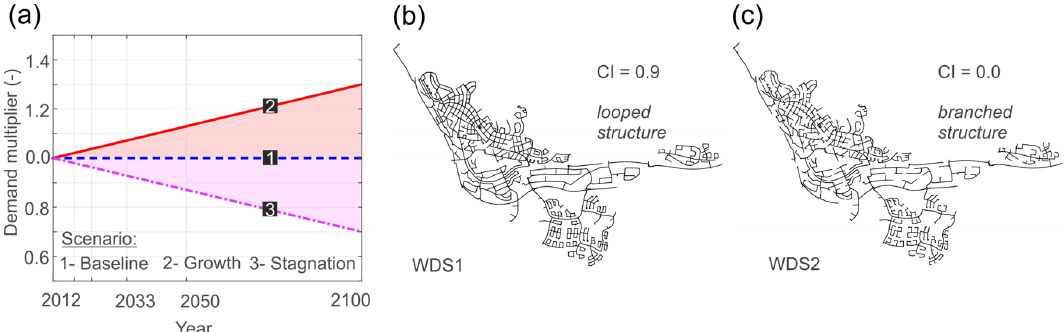
Figure 6. Future demand scenarios ( a ) and two possible planning options (WDS1 & WDS2) with different network structure ( b ) and ( c ).